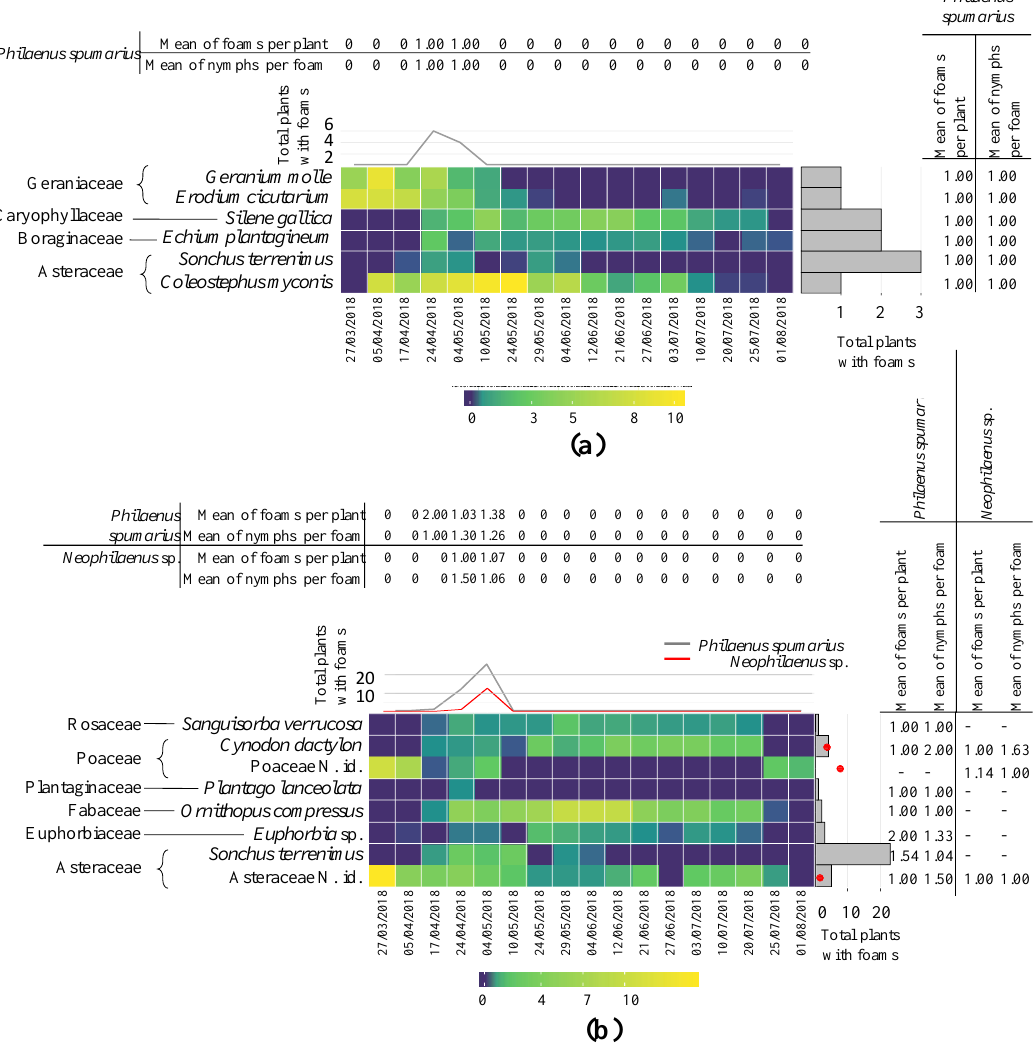
Figure 4. Heatmap plot showing 2018 data: ( i ) the percentage of plants with foam of all plants within a taxon (dark purple to yellow) (only host plants shown); ( ii ) total plants with foams of Philaenus spumarius (grey line) and Neophilaenus sp. (red line) during the collection period (top graphs); ( iii ) the total plants with P. spumarius (bars) and Neophilaenus sp. (points) foams in the identified plants (right graph); ( iv ) mean foams of P. spumarius and Neophilaenus sp. per plant and date; and ( v ) mean nymphs per foam of P. spumarius and Neophilaenus sp. per plant and date. ( a ) Abandoned olive orchard (UNP). ( b ) Productive integrated olive orchard (UP) N. id after taxa means not identified specimens belonging to that group. Families are indicated at the left of the plant species.